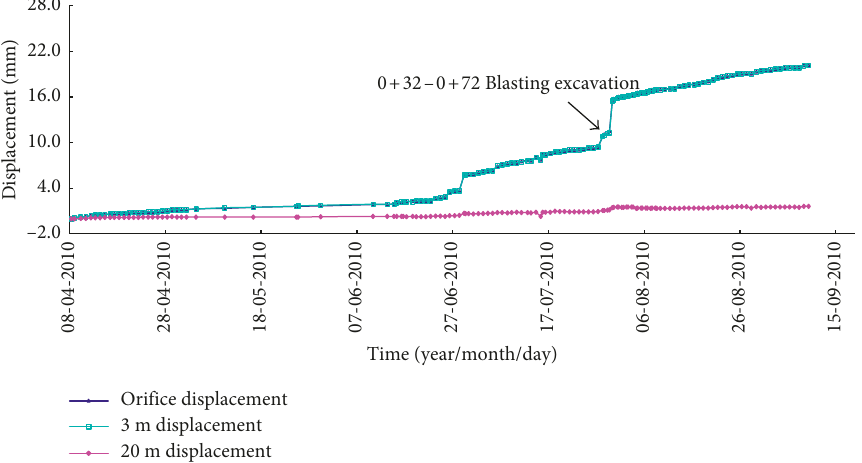
Figure 5: Absolute displacement recorded by the multipoint extensometer M 3 1,075m of the dam foundation